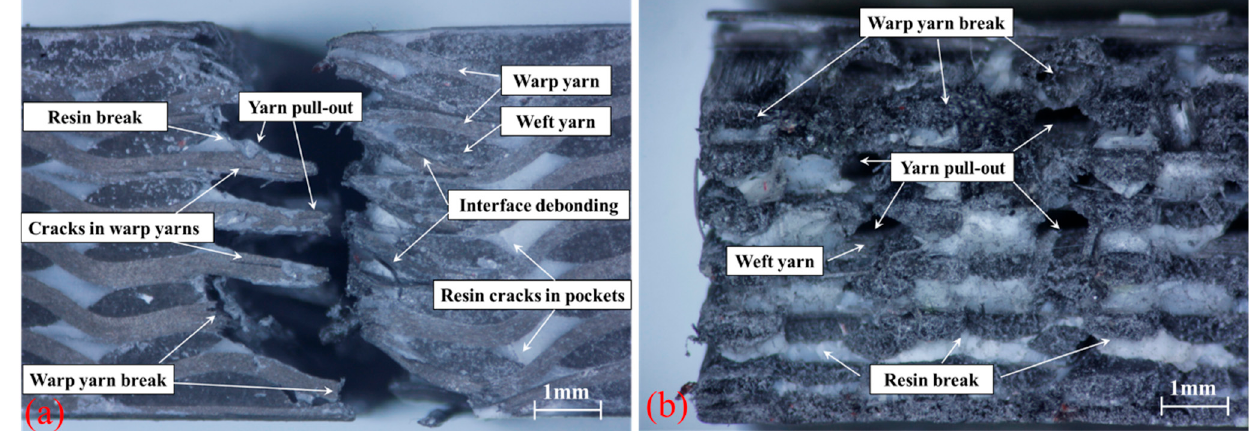
Figure 6. The tensile fracture morphology: the front view ( a ) and the inner left view ( b